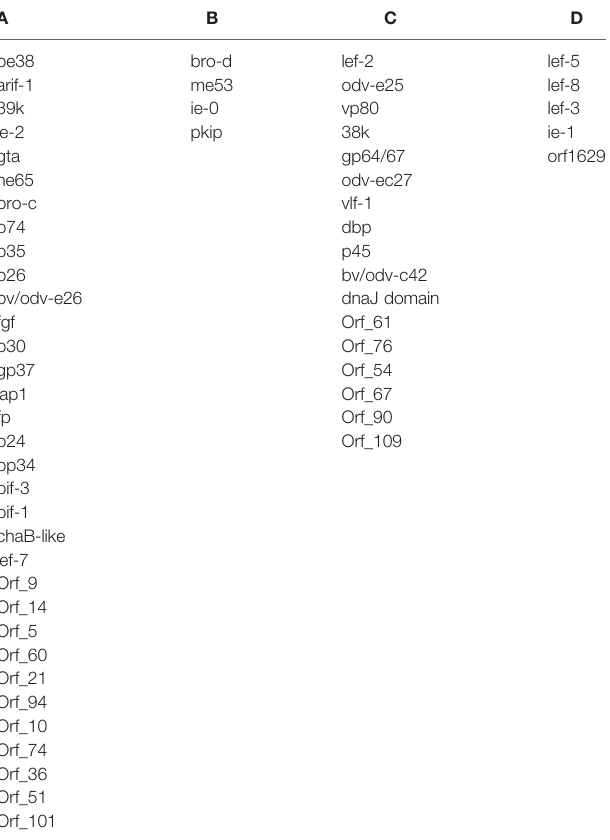
TABLE 2 | The KOV (bacmid)s were subdivided into four phenotypes (A to D) according to the results from the knockout BmNPVs (KOVs) for each viral gene using the lambda red recombination